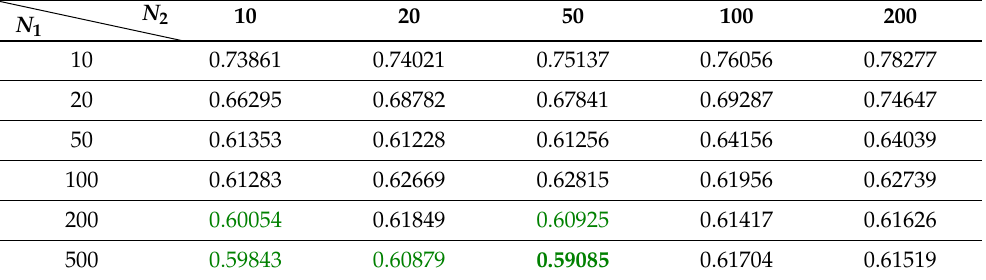
Table 2. Error RMS of NN on test dataset for different numbers of neurons in first and second layer in case of sigmoid activation function (lower values correspond to better